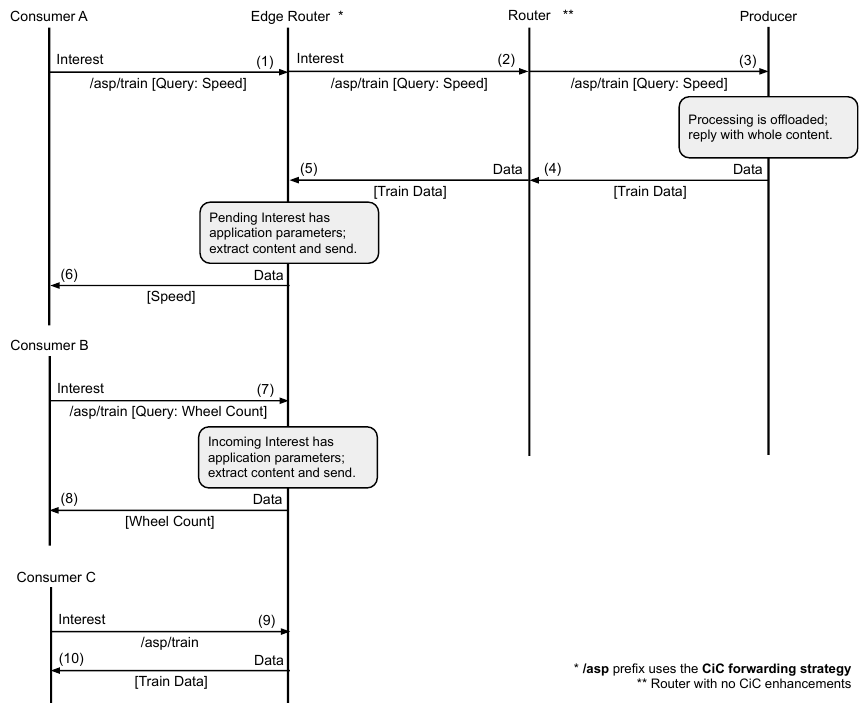
Figure 6. CiC Forwarding: message sequence